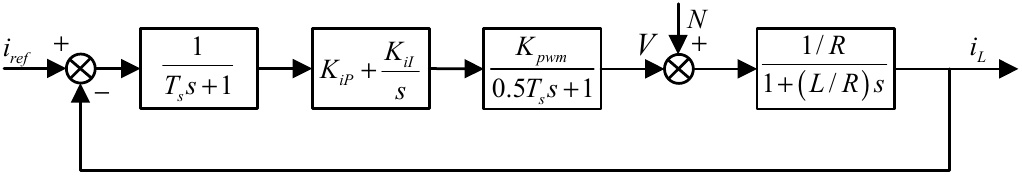
Figure 7. Block diagram of current closed-loop control.